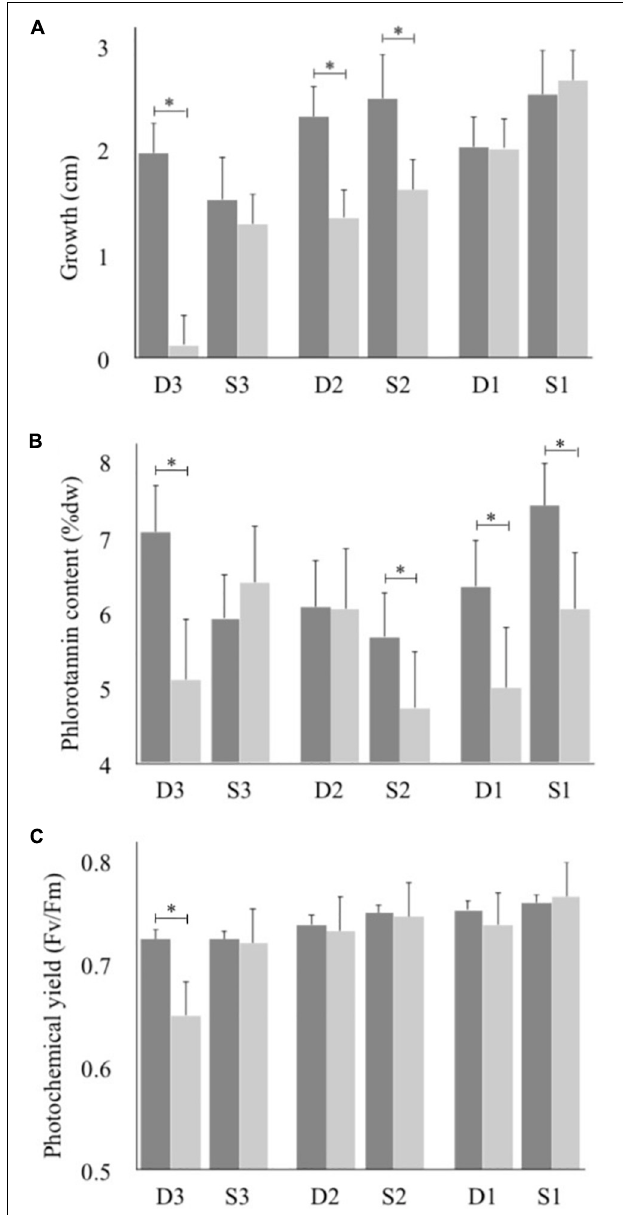
FIGURE 2 | (A) Growth measured as increase in length, (B) Phlorotannin content, (C) Efficiency of photosystem I ( F v / F m ). Dark bars represent current conditions and light bars represent future conditions, values are means ± 95% CI, n = 24. Data analyzed with paired t -tests for effect of treatment